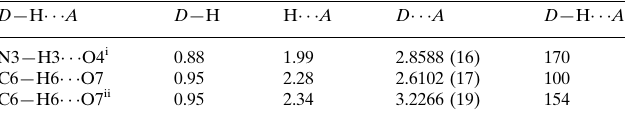
Hydrogen-bond geometry (A˚ , (cid:2)